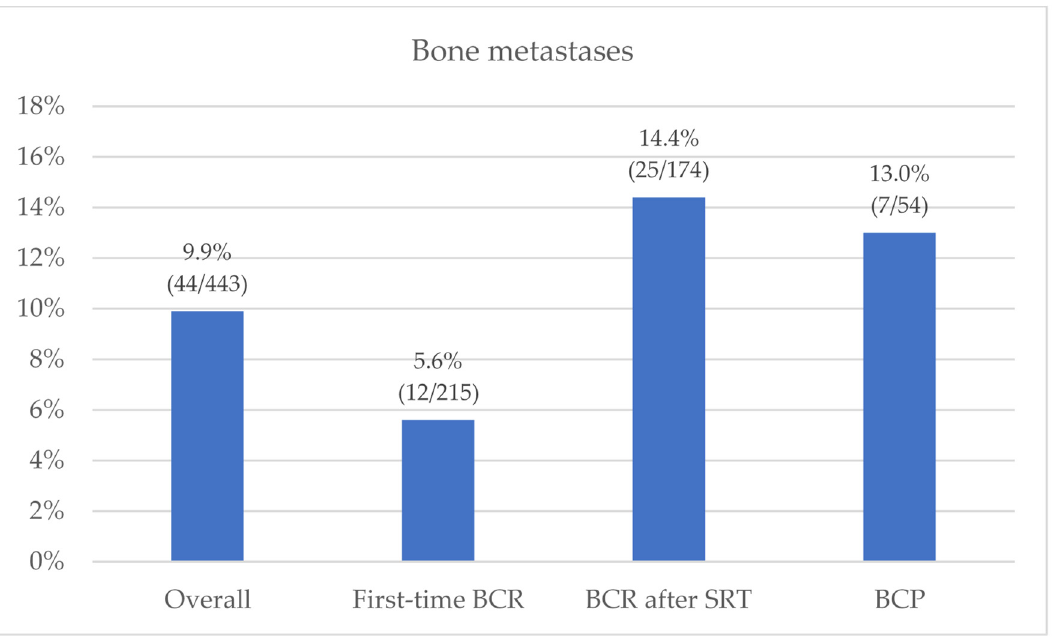
Figure 2. Bone metastases prevalence at PSMA-PET, stratified by clinical setting ( N = 443).